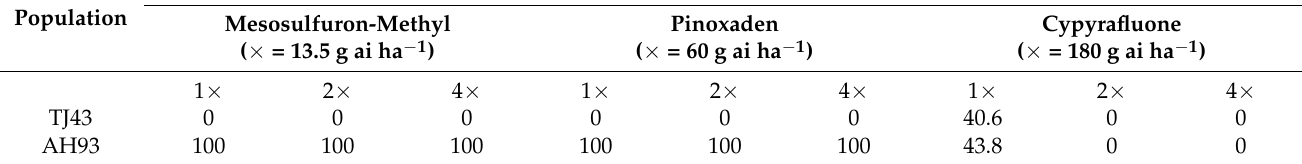
Table 2. Plant survival rates of the TJ43 and AH93 Alopecurus myosuroides populations 21 days after herbicide treatment. Plant Survival Rate at 1 × , 2 × and 4 × the Recommended Dose (%)